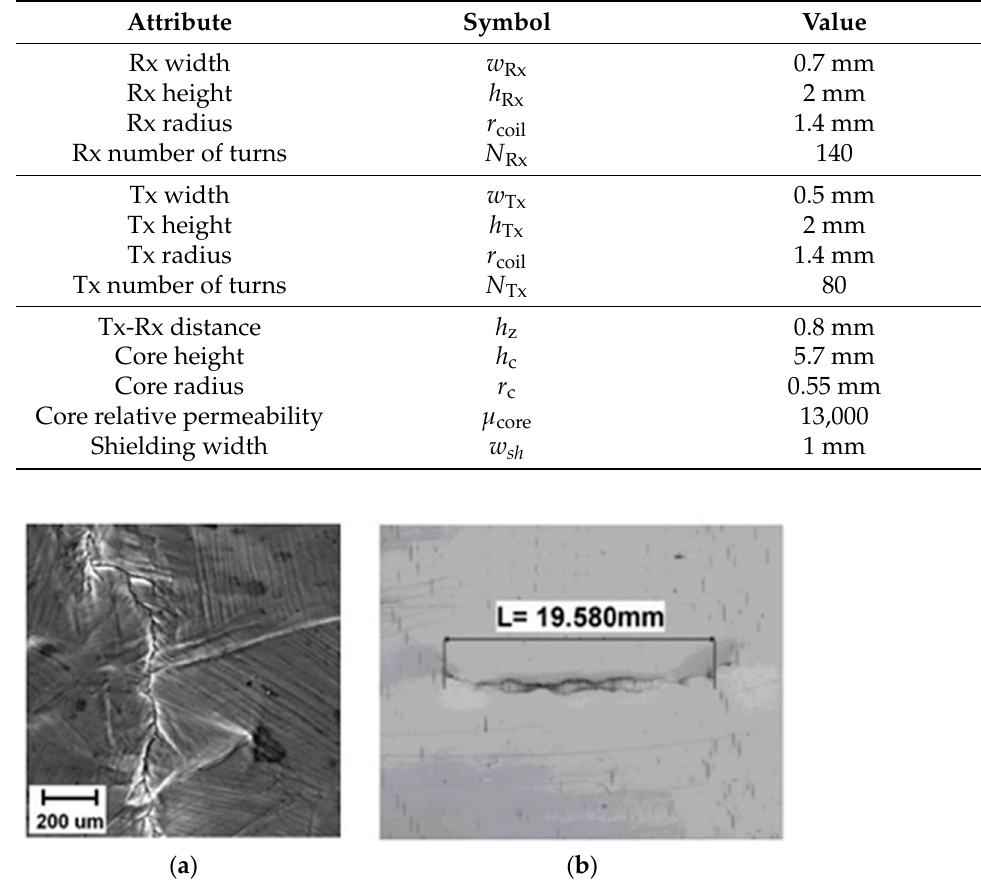
Figure 3. Microscopic images of the inspected AISI 316L corrosion cracks: cross -section ( a ) and the view from above ( b ).